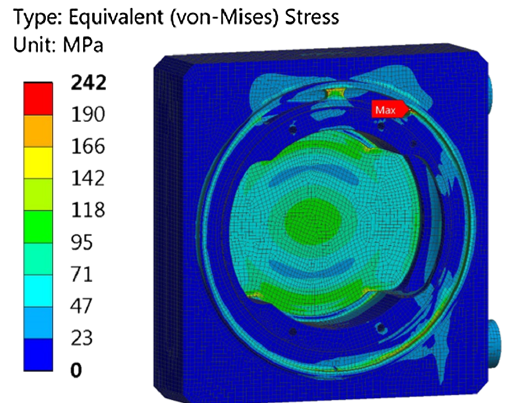
FIG. 18. Maximum stress distribution in the first support and beam window at an overpressure of 32 bar, calculated by means of FEM simulations. The maximum von Mises equivalent stress in the beam window is around 100